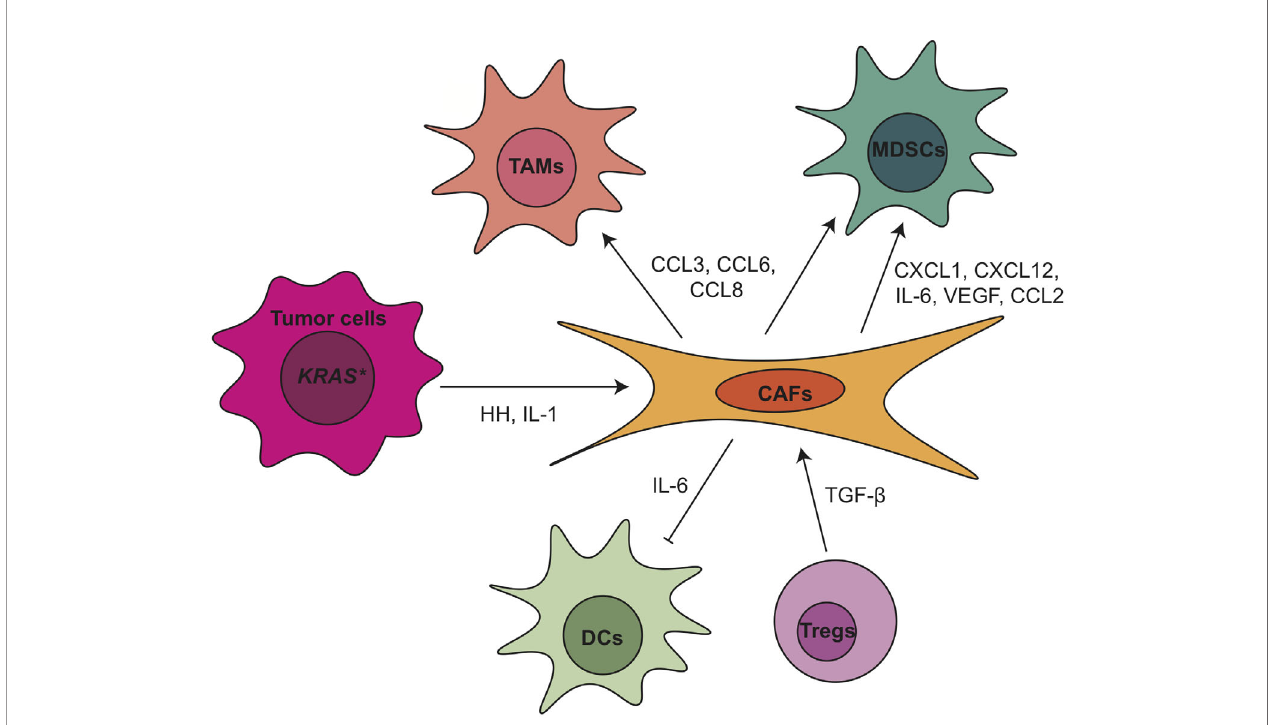
FIGURE 3 | Crosstalk between tumor associated fi broblasts and other TME components within pancreatic cancer. CAF, cancer associated fi broblasts; CCL, C-C motif chemokine ligand; CXCL, C-X-C motif chemokine ligand; DC, dendritic cell; HH, hedgehog; IL, interleukin; MDSCs, myeloid-derived suppressor cells; TAMs, tumor associated macrophages; TGF- b , transforming growth factor b ; Tregs, regulatory T cells; VEGF, vascular endothelial growth